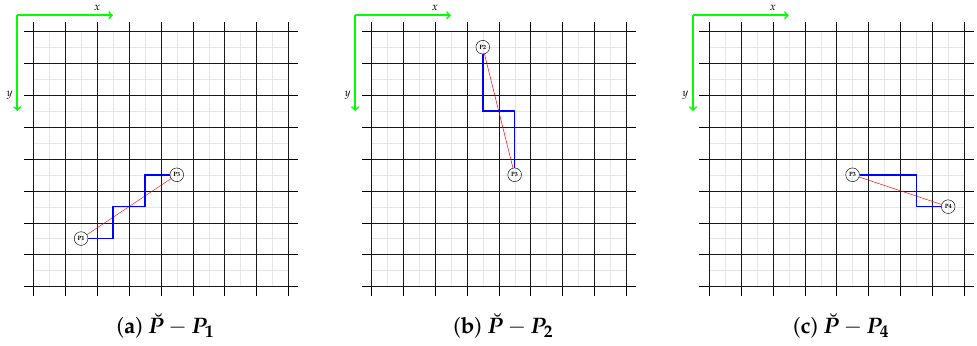
Figure 8. Multilateral well trajectory with nodal center point ˘ P .